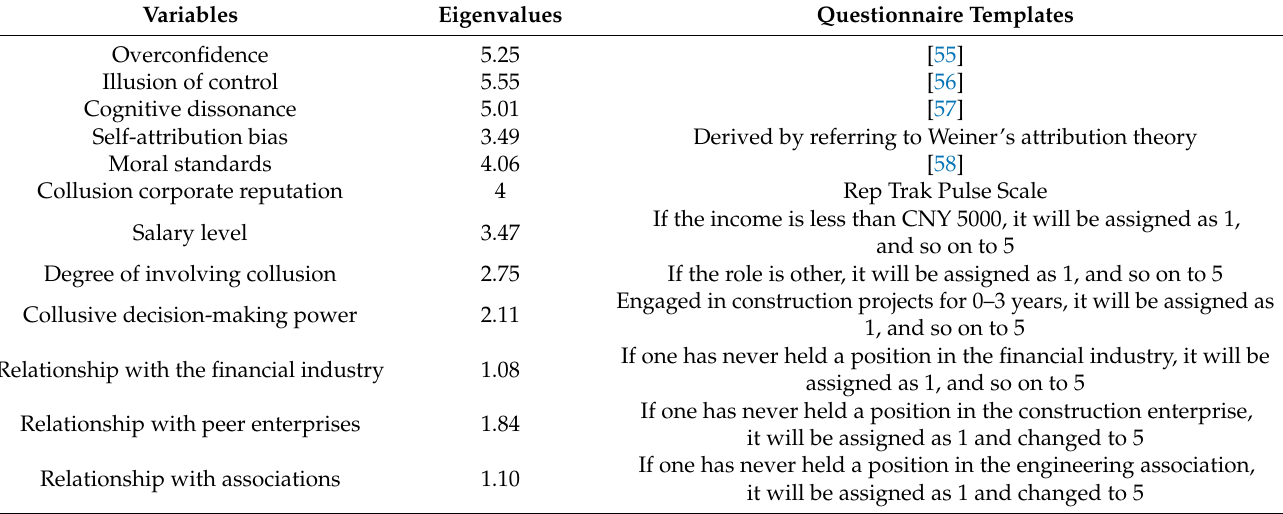
Table 3. Eigenvalues of the main